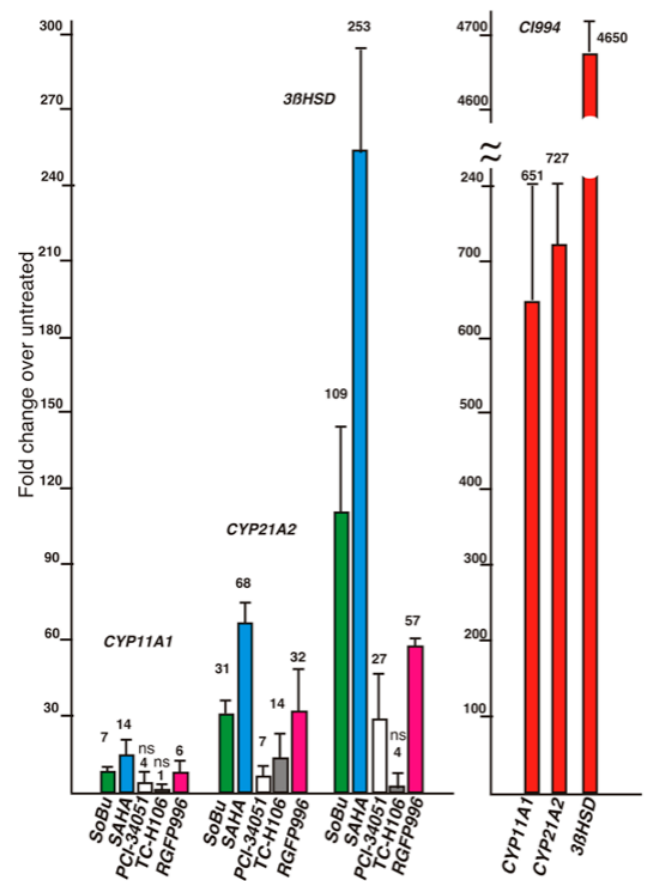
Figure 5. Several HDAC inhibitors were compared for their ability to induce differentiation in the HAA1 cells. CI-994 is the most potent inducer of steroidogenic differentiation in HAA1 cells. All values are significant ( p < 0.05 or less) except those indicated with “ns”. Table 1. Ingenuity Pathway Analysis of gene expression in HAA1 cells. Summary of Analysis-HAA1 for